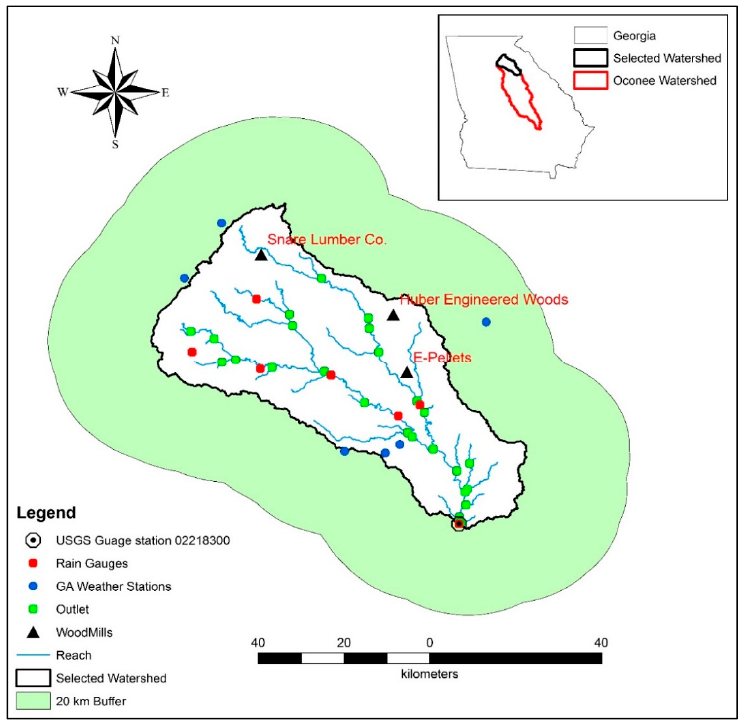
Figure 1. The selected watershed in the Oconee River Basin.